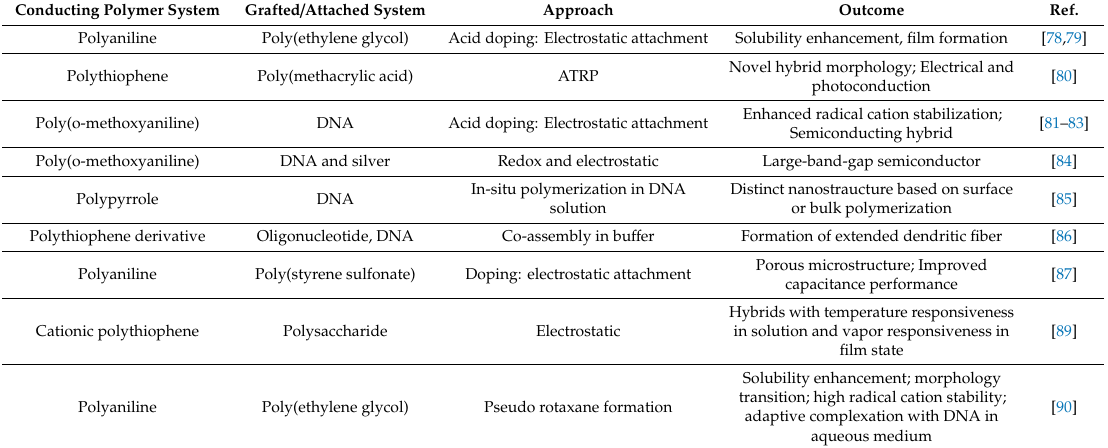
Table 2. Representative important research works done in the field of non-covalent grafting of conducting